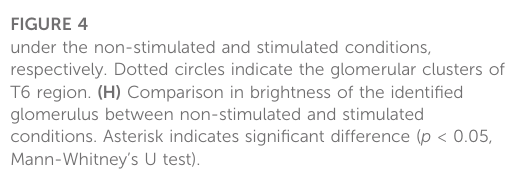
Figure 5A Middle. This glomerulus was not activated without vapor stimulation with benzaldehyde (Figure 5B, arrowhead).